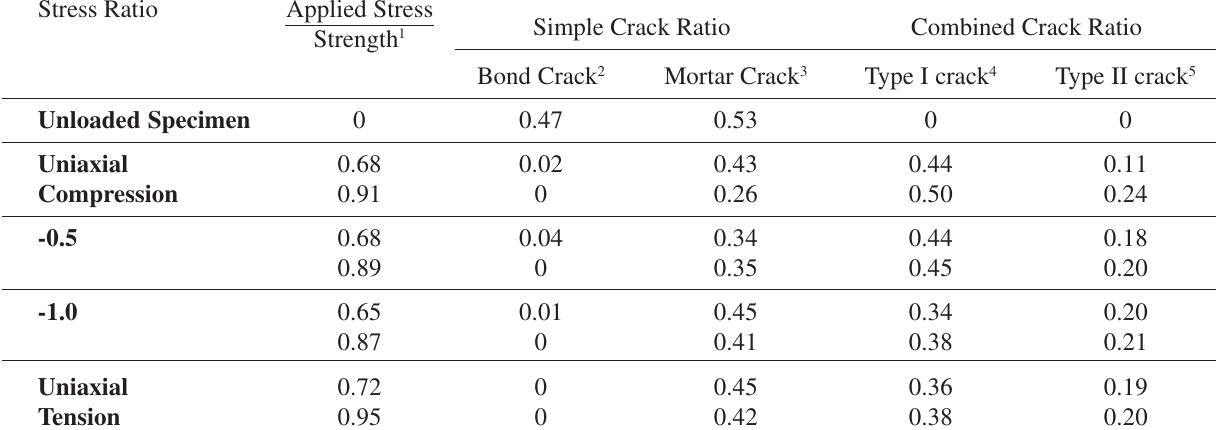
Table 1. Microcracking Analysis.